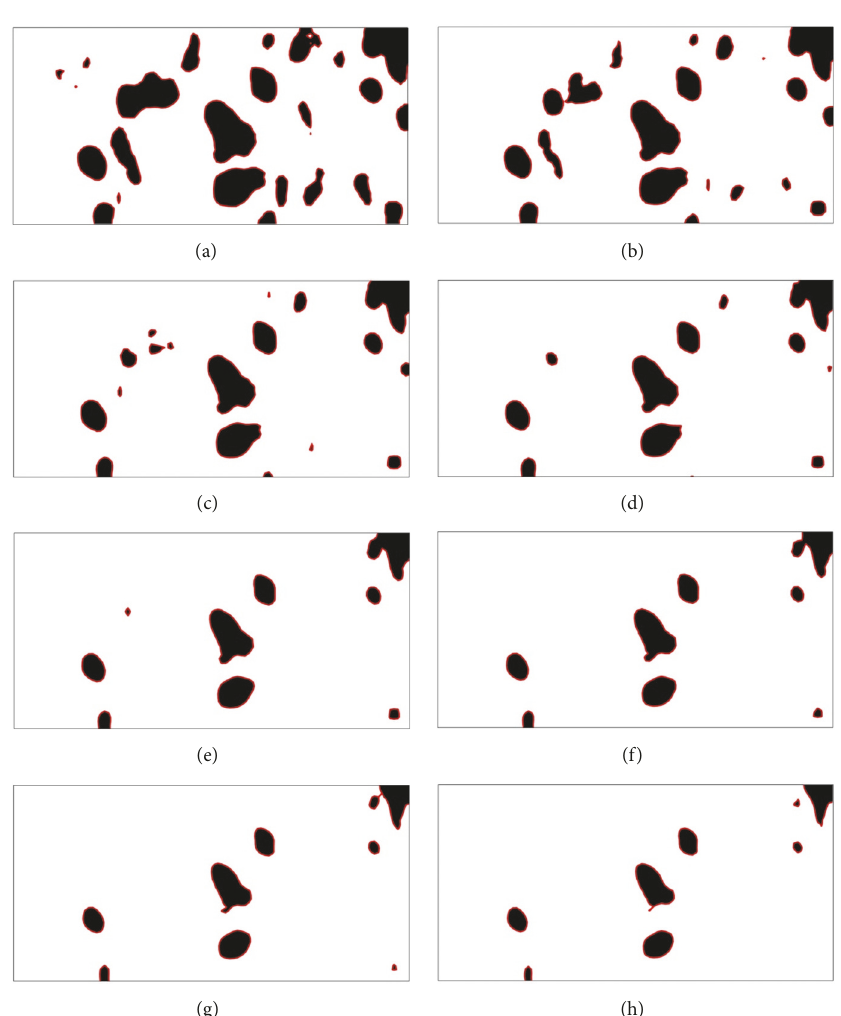
Figure 7: Black and white images of the maps displayed in Figure 6. The size of the images is 510 pixels by 255 pixels (381